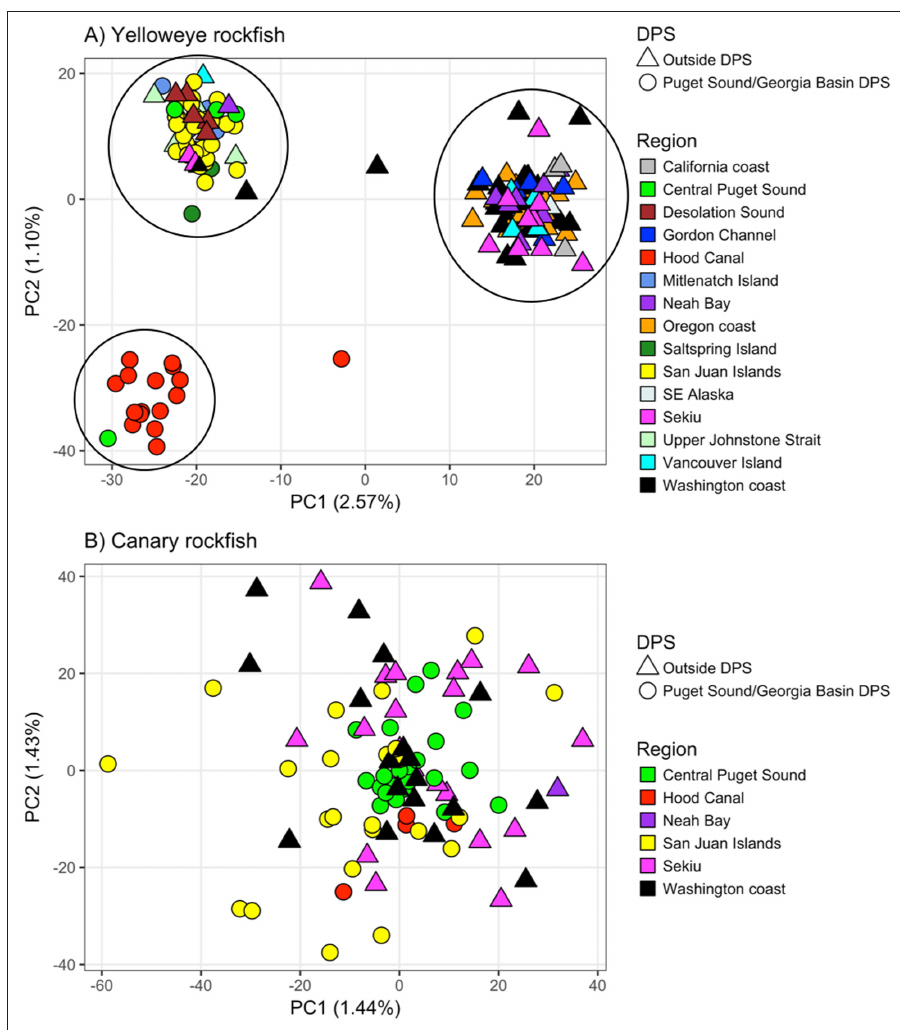
Figure 7: Principal components analysis reveals A) three population clusters for yelloweye rockfish and B) no popula- tion structure for canary rockfish across sampled geographic regions. Each symbol represents an individual fish from locations identified by shape and color of symbol. DPS: The original distinct population segment shown in Fig. 1. Reprinted by permission from Springer Nature: Conservation Genetics Andrews et al.